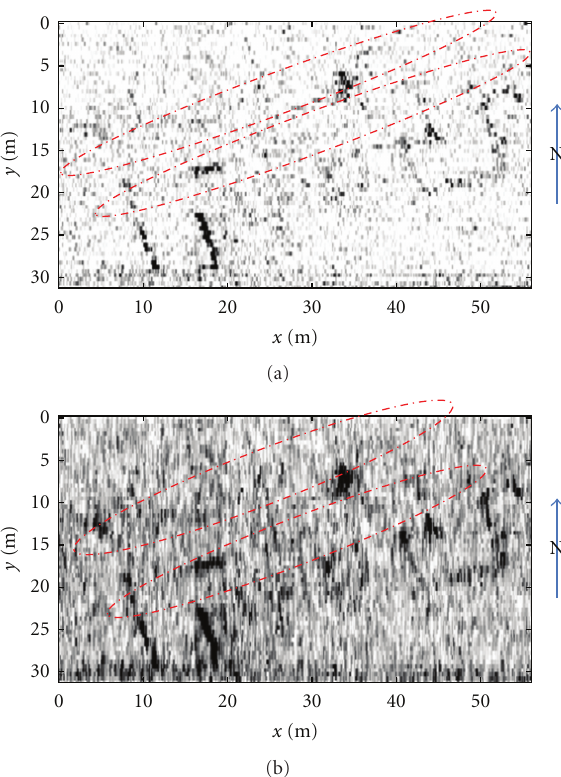
Figure 11: Tomographic constant depth slice at 0.75m: (a) section not interpolated; (b) section interpolated by a median